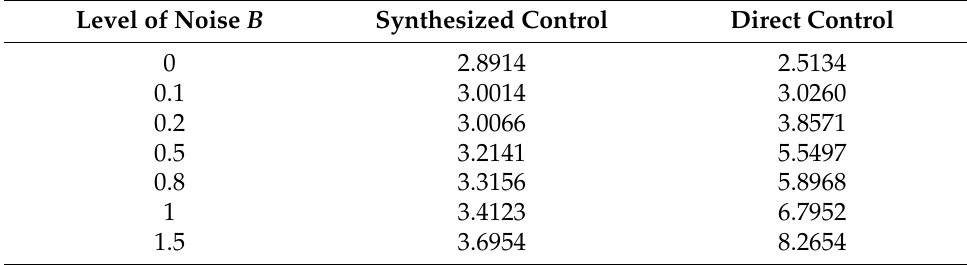
Table 1. The average values of functional (70).